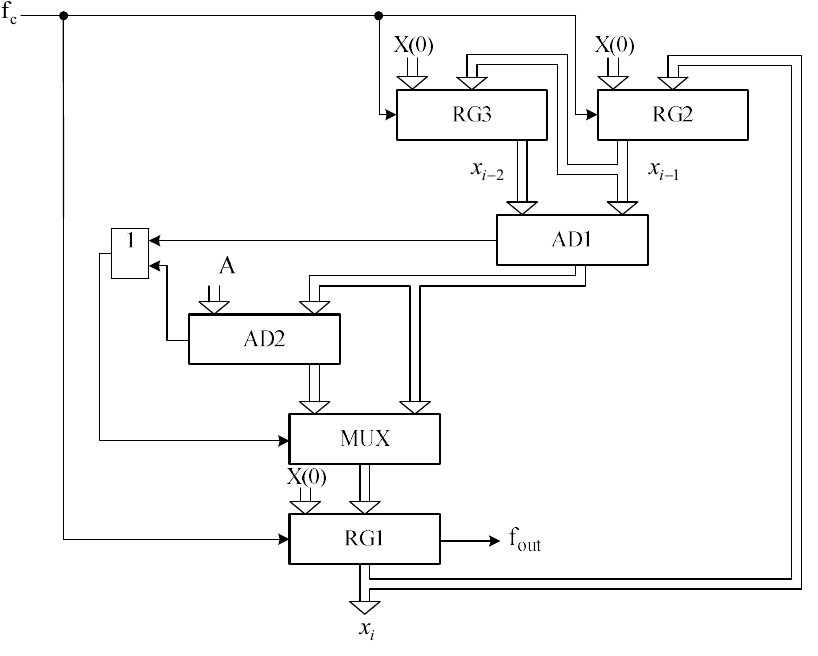
Figure 1. Structure schema of AFG.